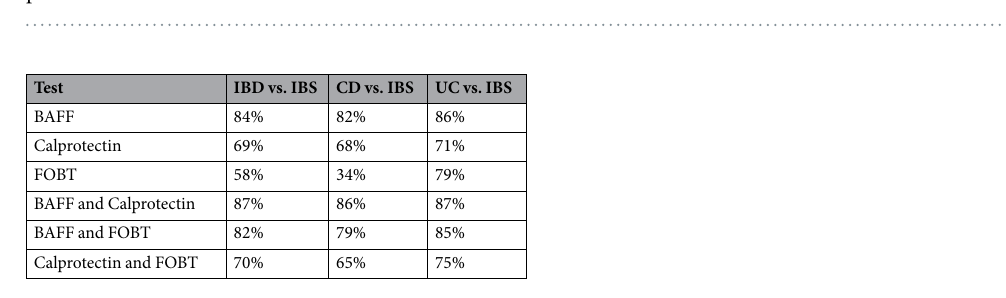
Table 5. Accuracy of Faecal Markers and Combined Faecal Markers. CD, Crohn’s disease; UC, ulcerative colitis; IBS, irritable bowel